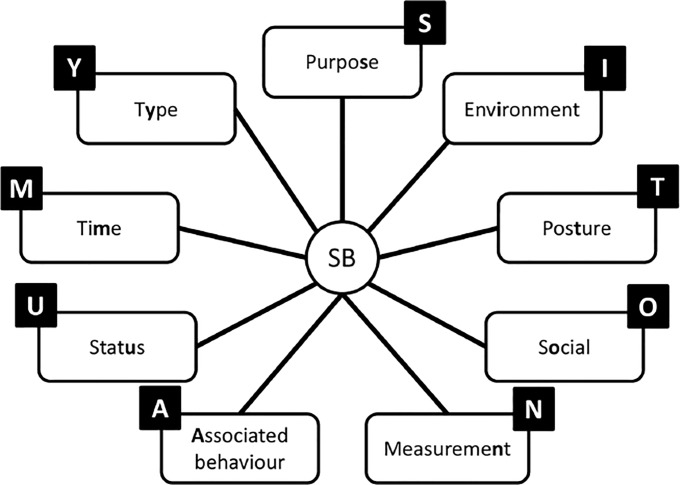
Taxonomy level one.